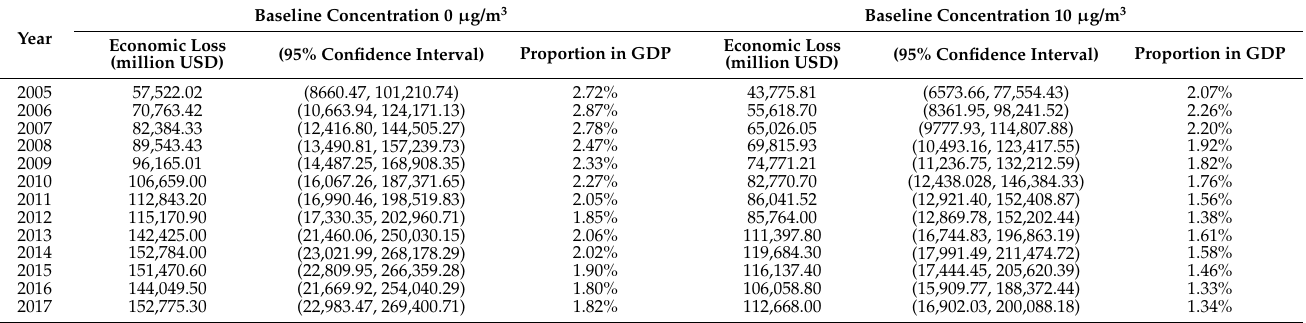
Table 5. The comparison of economic loss upon exposure to PM 2.5 at different baseline